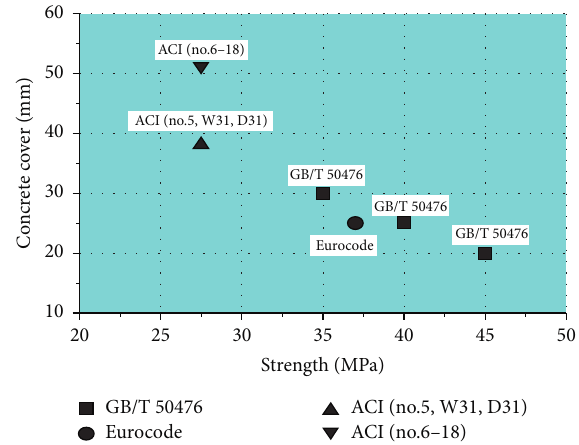
Figure 7: Required concrete strength and thickness of concrete cover for atmospheric environments from Eurocode, ACI-318, and GB/T 50476 [54,